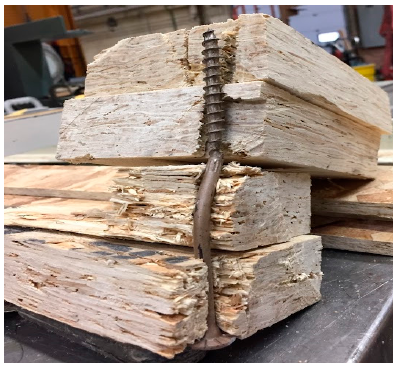
Figure 24. Failure mode of